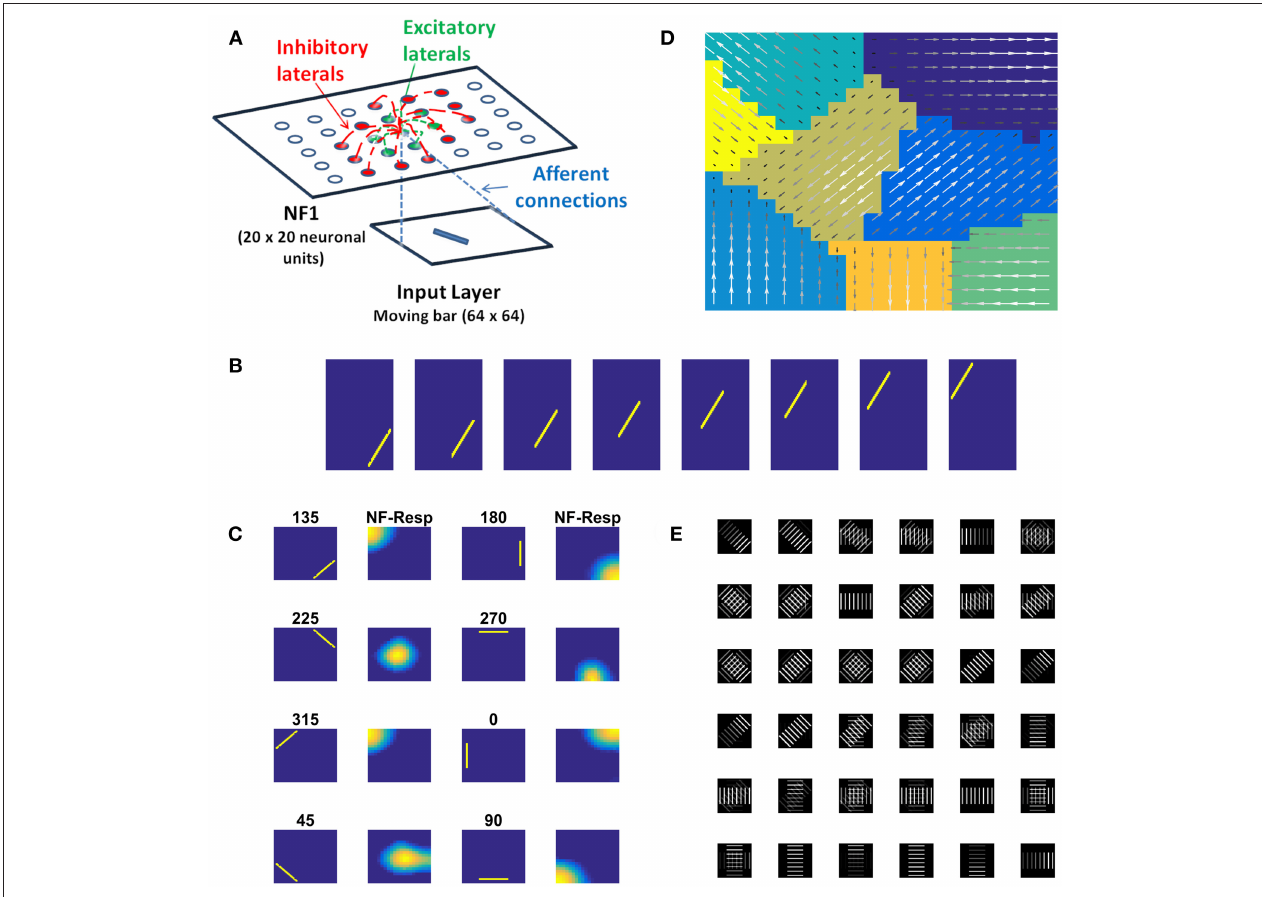
FIGURE 2 | Direction sensitivity. (A) The Architecture used to simulate the direction sensitivity of V1 cells : The model consists of two stages: (a) an input layer where moving bar is presented (b) NF (20 × 20 units) analogous to V1. Green arcs represent the excitatory connections and the red arcs represent the inhibitory connections. The afferent connections are represented with blue dotted lines (B) . Sample bar stimulus moving in 135 ◦ : the bar of size 30 × 2 pixels are placed on 64 × 64 pixels black background and is made to move in 8 directions with the direction of motion perpendicular to the orientation. The motion is captured in a sequence of 8 frames. (C) Network response to moving bar stimulus after 500 epochs of training : the first and the third columns display the first frame of the moving bar sequence, the label above it shows the direction of motion of the bar. The response of NF has plotted in the second and fourth columns. Each input is mapped to the unique spatial position on NF. (D) Direction selectivity map : Direction selectivity map is plotted using the convention described in the section “Generating topographic map.” We observed that the patch of neurons selective to one direction of motion often has an adjacent patch with opposite direction preference. The arrows indicate the direction preferences developed by the neurons on NF. The arrow with the highest magnitude indicates the peak response of the neuron (E) . The afferent weights developed by the selected neurons in NF : Initial afferent weights are random. After training Gabor like afferent weights are developed. Different varieties of tuned afferent weights (64 × 64 pixels each) are selected from the whole population ( Figure S1 ) and displayed